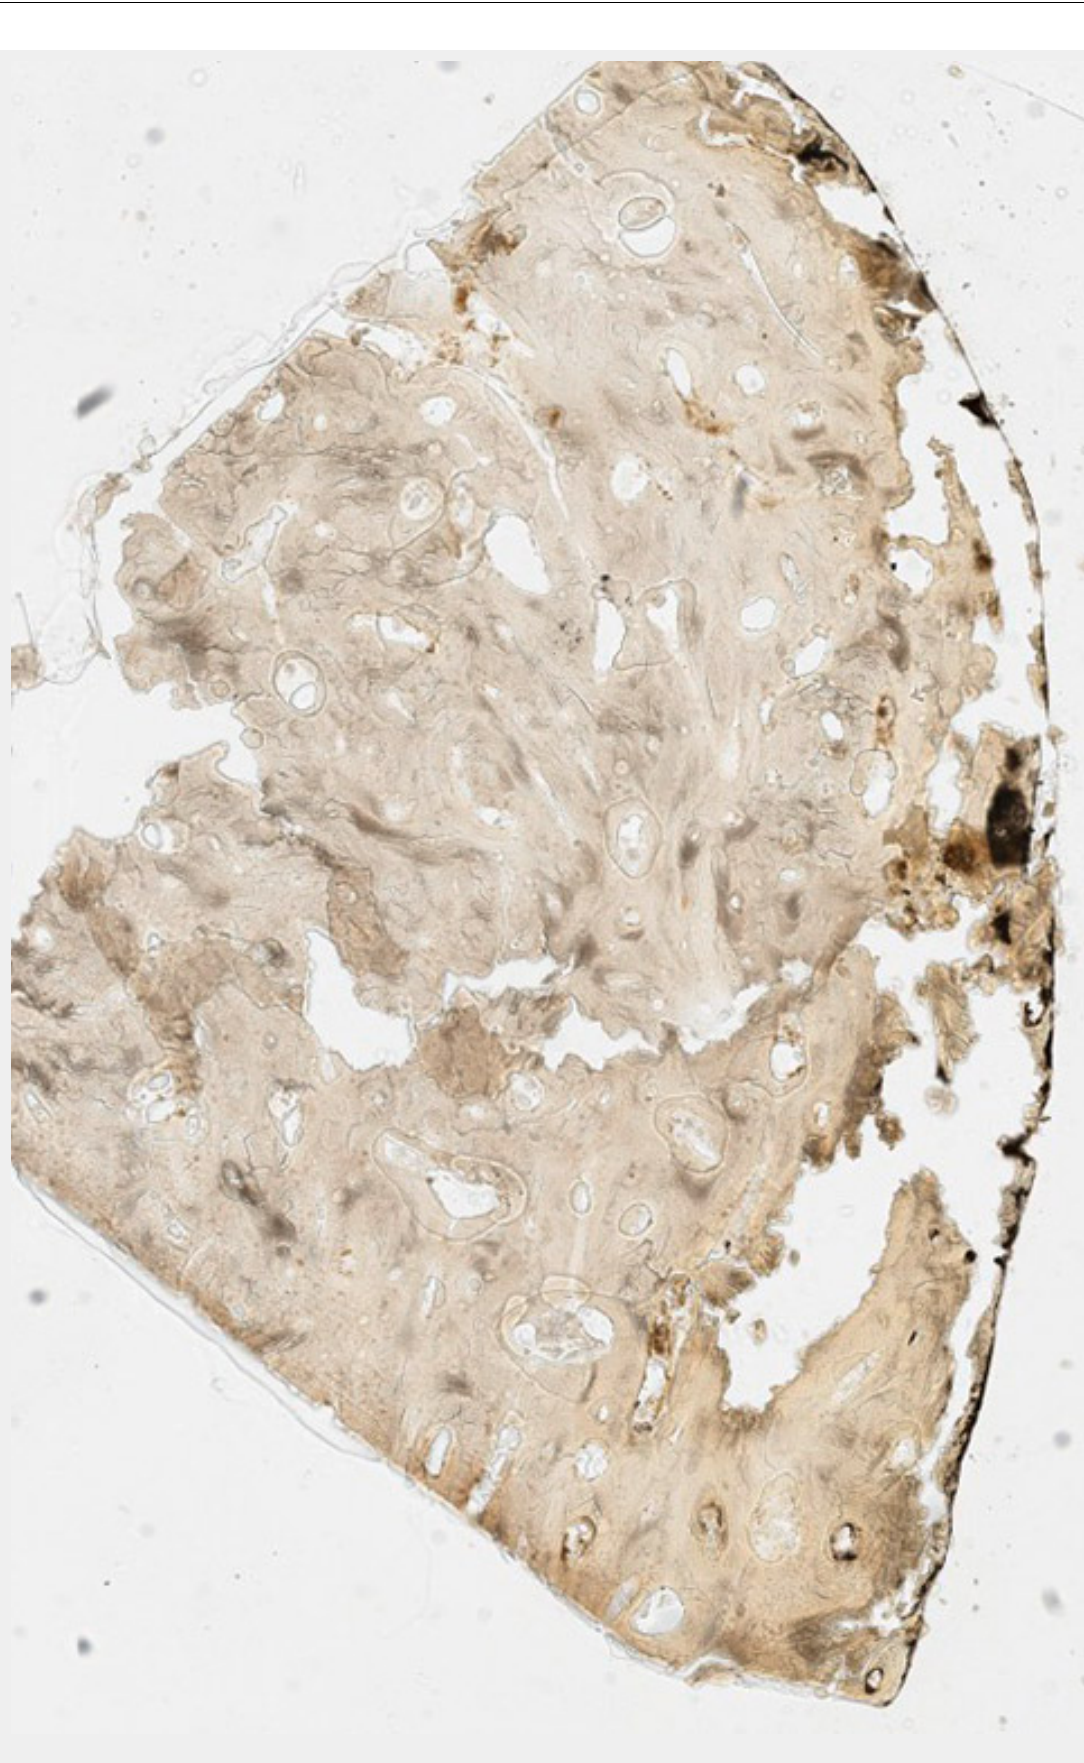
Figure 7 Hard-cut section 1.25x. Sample taken out of the